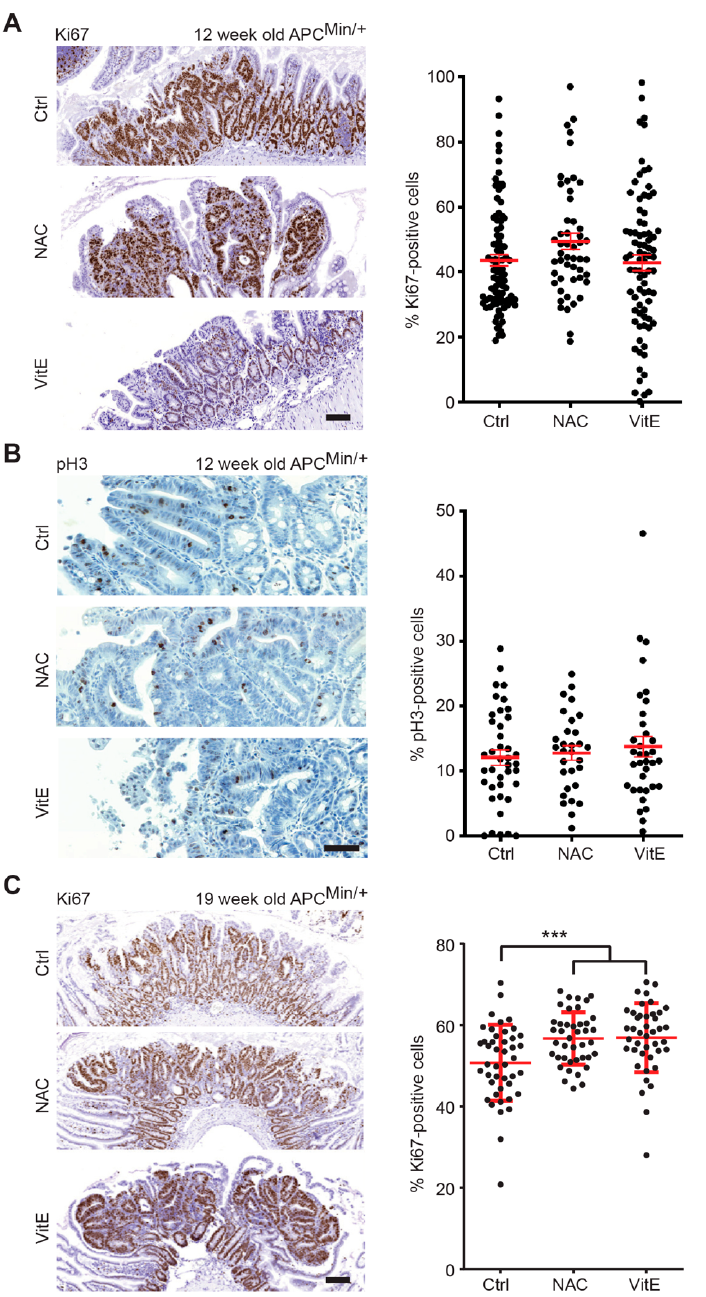
Figure 4. NAC and VitE increase tumor cell proliferation at 19 weeks of age. ( A , B ) Immunohis- tochemical staining of Ki67 ( A ) or phosphorylated histone 3 (pH3) ( B ) in adenomas from small intestines of APC Min/+ mice that were treated with NAC or VitE from two weeks before birth until 12 weeks of age or untreated controls. Antigen and treatment are indicated in the panels. Dot plots showing percent Ki67 or pH3-stained cells in individual tumors ( n = 50–90 tumors/group in A ; n = 30–40 tumors/group in B ). ( C ) Immunohistochemical staining of Ki67 in adenomas from small intestines of APC Min/+ mice that were treated with NAC or VitE from 12 to 19 weeks of age or untreated controls. Antigen and treatment are indicated in the panels. Dot plots showing percent Ki67 or pH3-stained cells in individual tumors ( n = 42-44 tumors/group). Scale bars are 10 µ m in ( A , C ) and 50 µ m in ( B ); error bars indicate SEM; *** p <